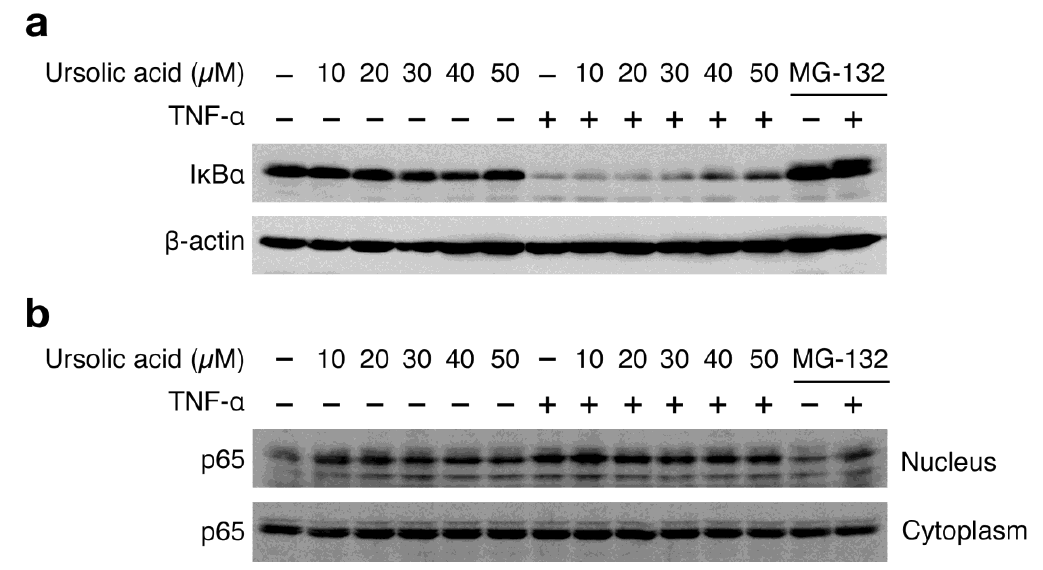
Figure 3. Ursolic acid does not efficiently inhibit TNF-α-induced NF-κB signaling pathway. ( a ) A549 cells were preincubated with indicated concentrations of ursolic acid or MG-132 (20 µM) or without any of those compounds (–) for 1 h and then incubated with (+) or without (–) TNF-α (2.5 ng/mL) for 15 min in the presence of those compounds. Cell lysates were analyzed by Western blotting; ( b ) A549 cells were preincubated with indicated concentrations of ursolic acid or MG-132 (20 µM) or without any of those compounds (–) for 1 h and then incubated with (+) or without (–) TNF-α (2.5 ng/mL) for 30 min in the presence of those compounds. Cell lysates were analyzed by Western